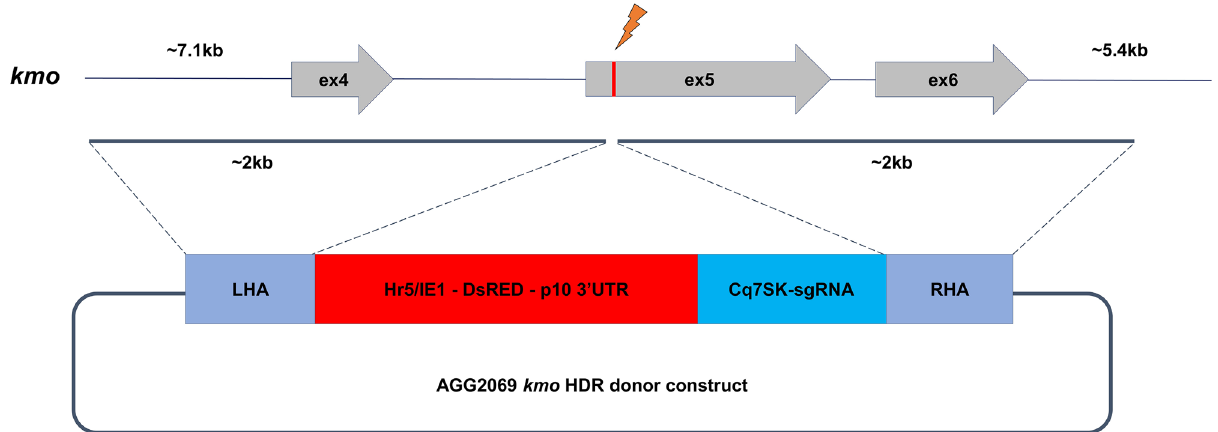
Figure 1. CRISPR/Cas9 based kmo knock-in cassette. Representation of the kmo locus and HDR donor construct for integration. Grey arrows represent exons and the red vertical line indicates the sgRNA target site within exon 5. The dark grey lines indicate the left and right homology arm sequences (LHA and RHA, respectively). In addition to a fluorescent marker, the knock-in cassette contains the C. quinquefasciatus 7SK promoter, an RNA Pol III promoter which expresses the same sgRNA used to integrate the cassette into kmo . This would allow an integration of this cassette to be combined with future cas9 expressing lines to test for homing